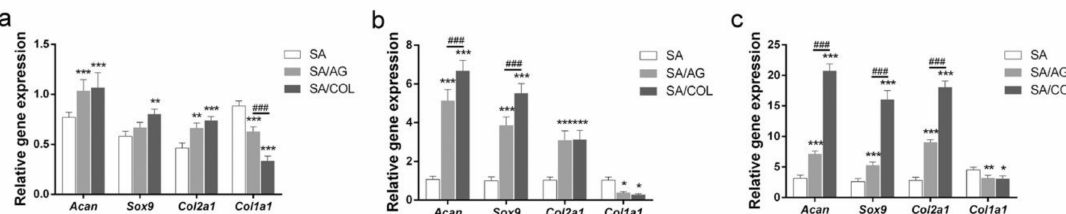
Figure 7. Expression level of genes including Acan, Sox9, Col2a1, and Col1a1 was determined by qRT-PCR. 3D constructs including SA, SA/AG and SA/Col in vitro after 3 days ( a ), 7 days ( b ), and 14 days ( c ). *, **, and *** indicated p < 0.05, p < 0.01 and p < 0.001 between SA/AG and SA/COL vs. SA. ### indicated p < 0.001 between SA/AG vs. SA/COL. Reproduced from [116] with permission. Copyright (2018)